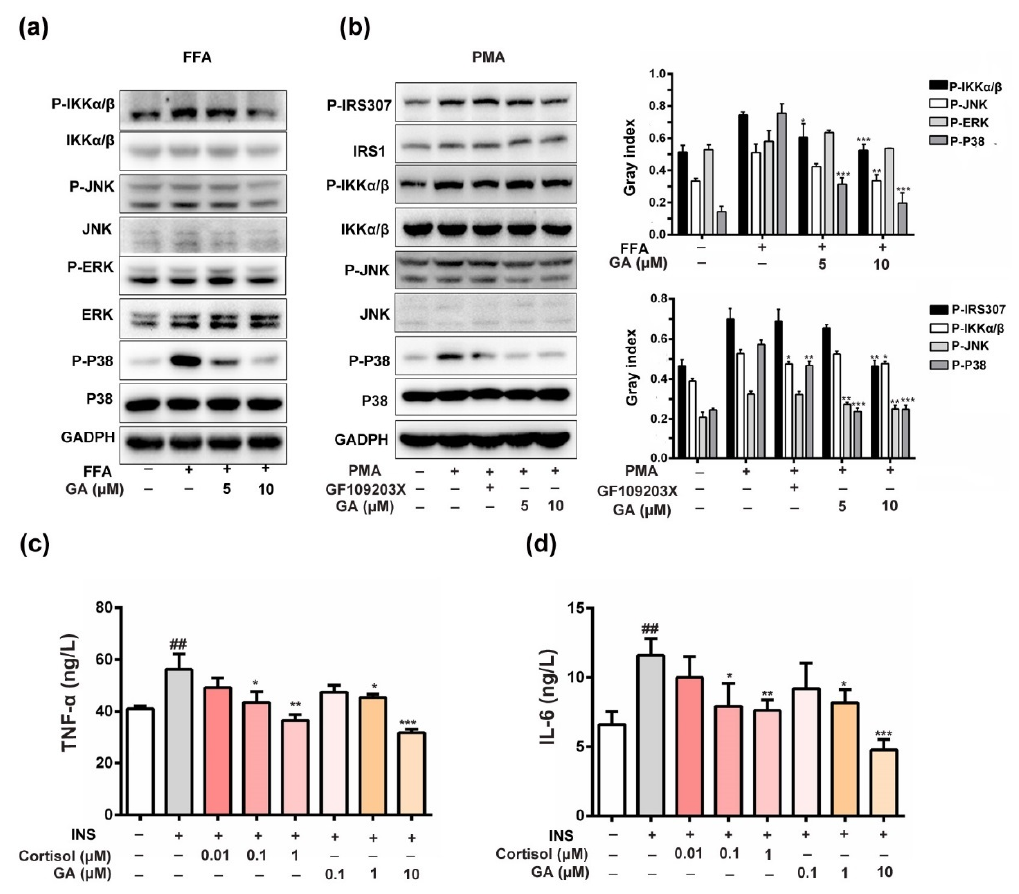
Figure 5. Effect of GA on the anti-inflammatory andinsulin-responsive pathways. ( a ) The total ERK1/2, JNK, p38, and IKK and the phosphorylation of ERK1/2, JNK p38 and IKK were detected in the cells. ( b ) GA blocked the PMA-induced (1 µ M) PKC activities and inhibited PKC-induced phosphorylation of IRS1ser307, IKK, p38 and JNK activation. ( c , d ) The effect of GA on TNF- α and IL-6 levels in the activated insulin signaling pathway. To examine the effect of GA on the inflammatory cytokines, the levels of TNF- α and IL-6 in the activated insulin signaling pathway was measured by ELISA. HepG2 cells were incubated for 36 h in serum-free DMEM containing 1 µ M insulin. The level of TNF- α and IL-6 in the activated insulin signaling pathway was significantly higher compared with the control cells. After treatment with GA (0.1, 1 and 10 µ M), the level of TNF- α and IL-6 in the culture medium was significantly lower compared with the activated insulin signaling pathway. Cortisol (0.01, 0.1 and 1 µ M) was also able to decrease the levels of TNF- α and IL-6 in the culture medium compared with the activated insulin signaling pathway. The error bars indicate the mean ± S.D ( n = 3) (* p < 0.05, ## p < 0.01, ** p < 0.01, *** p < 0.001 compared to the activated insulin signaling pathway group).